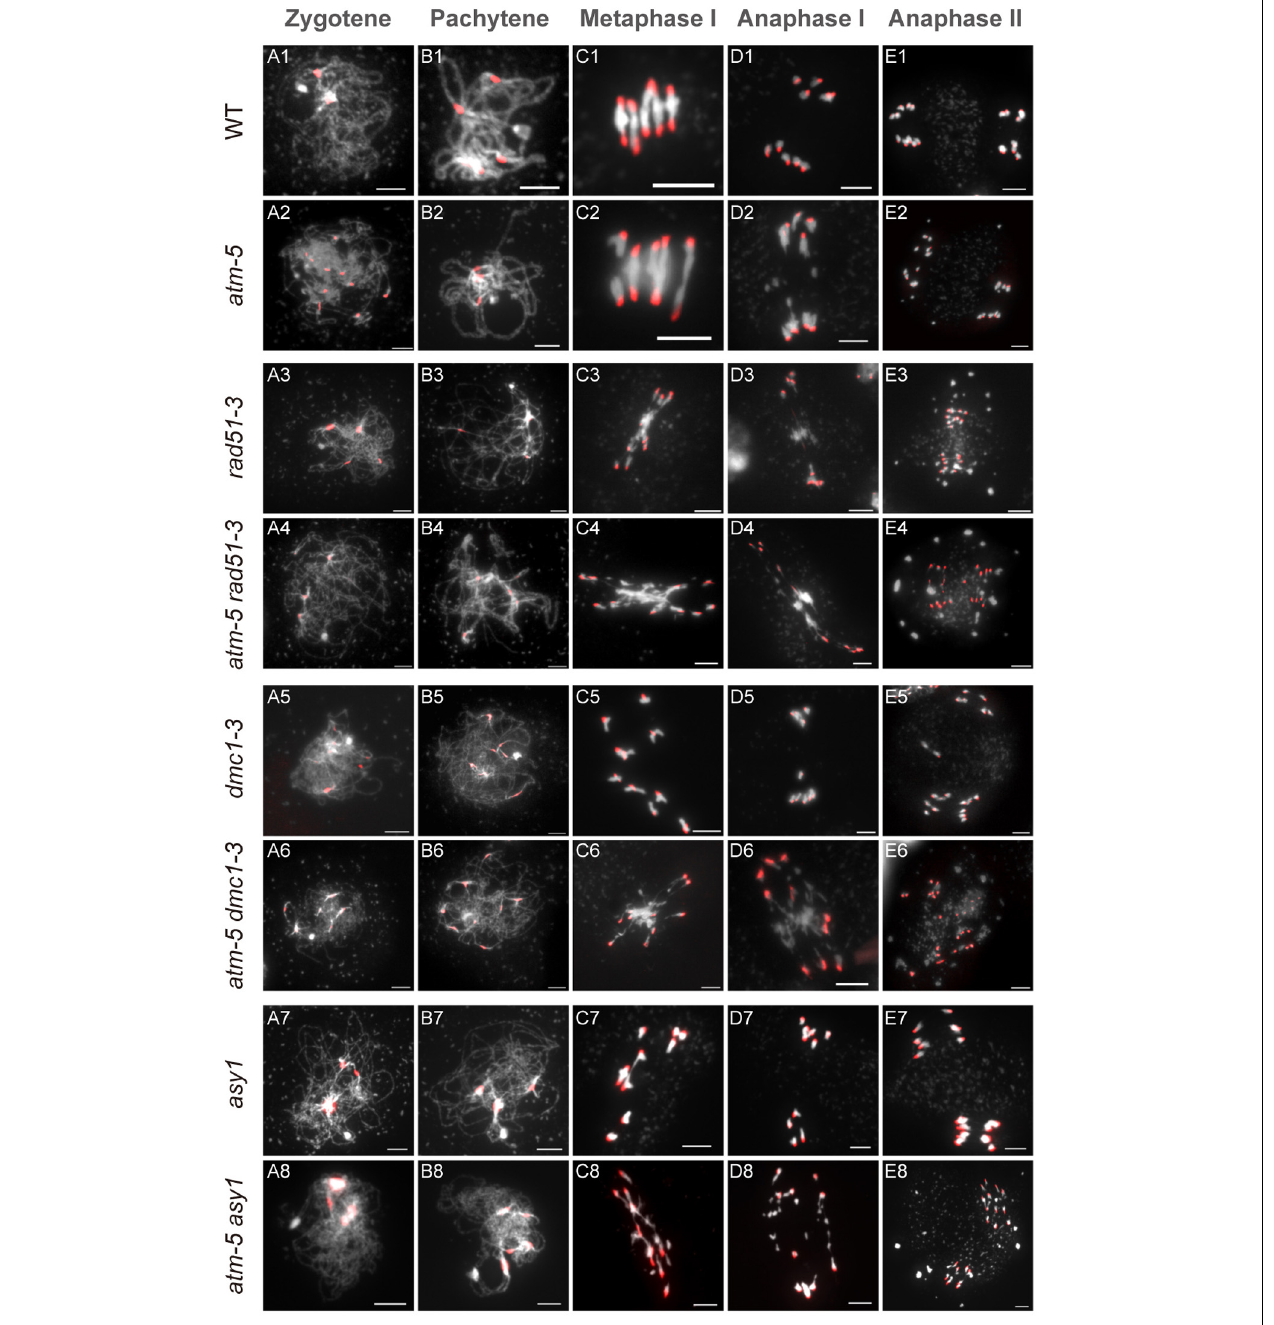
FIGURE 6 | Chromosome morphology analysis of male meiocytes in different alleles. Wild type (WT) (A1–E1) , atm-5 (A2–E2) , rad51-3 (A3–E3) , atm-5 rad51-3 (A4–E4) , dmc1-3 (A5–E5) , atm-5 dmc1-3 (A6–E6) , asy1 (A7–E7), and atm-5 asy1 (A8–E8) chromosome morphologies at zygotene, pachytene, metaphase I, anaphase I, and anaphase II. Centromere signals are in red. Bar = 5 µ